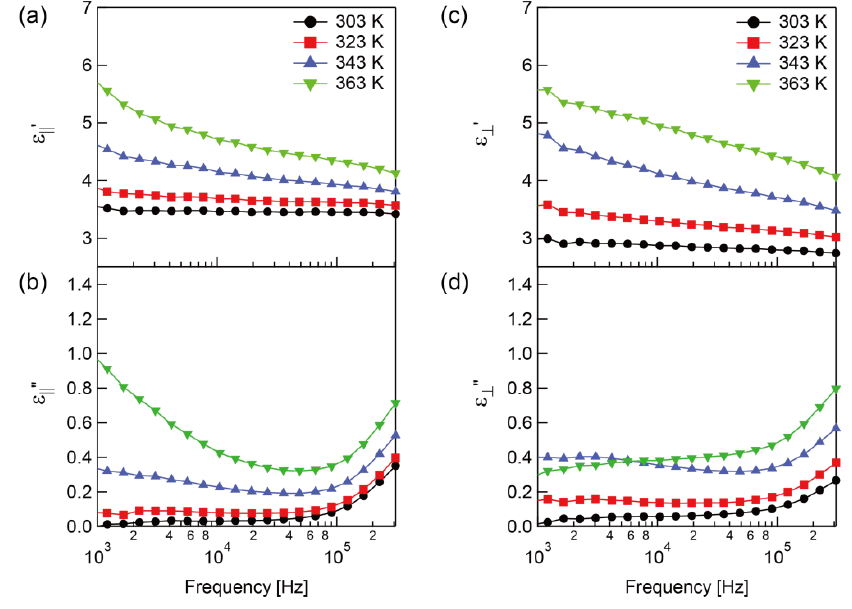
Figure 5. Measured complex dielectric constants after polymerization. The ( a ) real part and ( b ) imaginary part of complex dielectric constant parallel to the molecular long axis and the ( c ) real part and ( d ) imaginary part of complex dielectric constant perpendicular to the molecular long axis.